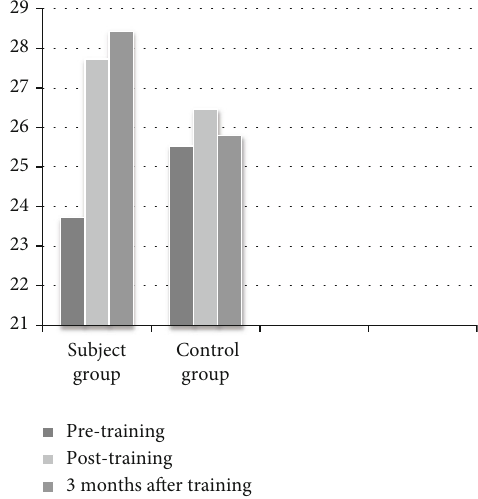
Figure 3: Distribution of participants ’ scores from the Functional Reach